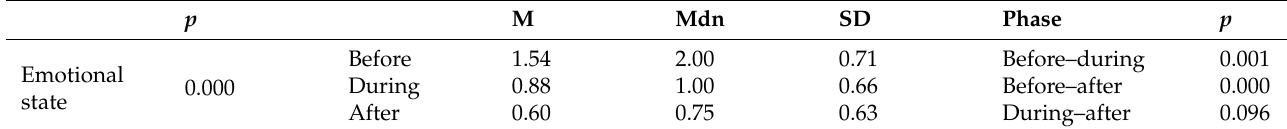
Table 2. Emotions before, during, and after VR exposure using VAS.